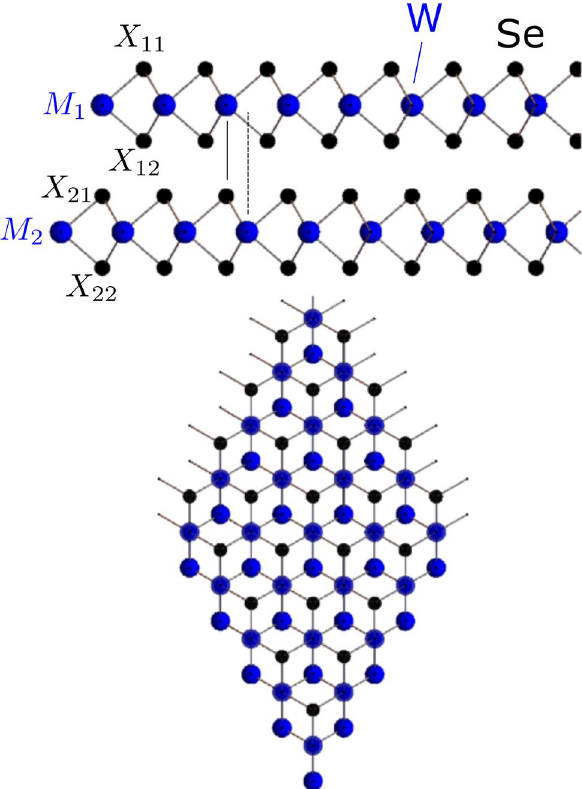
Figure 1. Upper and lower panels: top and side view, respectively, of XM ′ -stacked WSe 2 (the prime indicating that of the vertical metal(M)–chalcogen(X) pair, the metal atom is in the top layer). The solid and dashed vertical lines in the upper panel emphasise the symmetry-breaking of this stacking, with the metal–chalcogen pair vertically opposite in one direction, but not in the other. The italicised labels in the upper panel ( M 1 , X 12 etc.) indicate the atomic positions referred to in Table